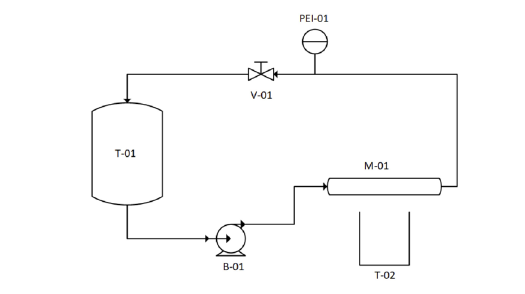
Figure 1. Filtration